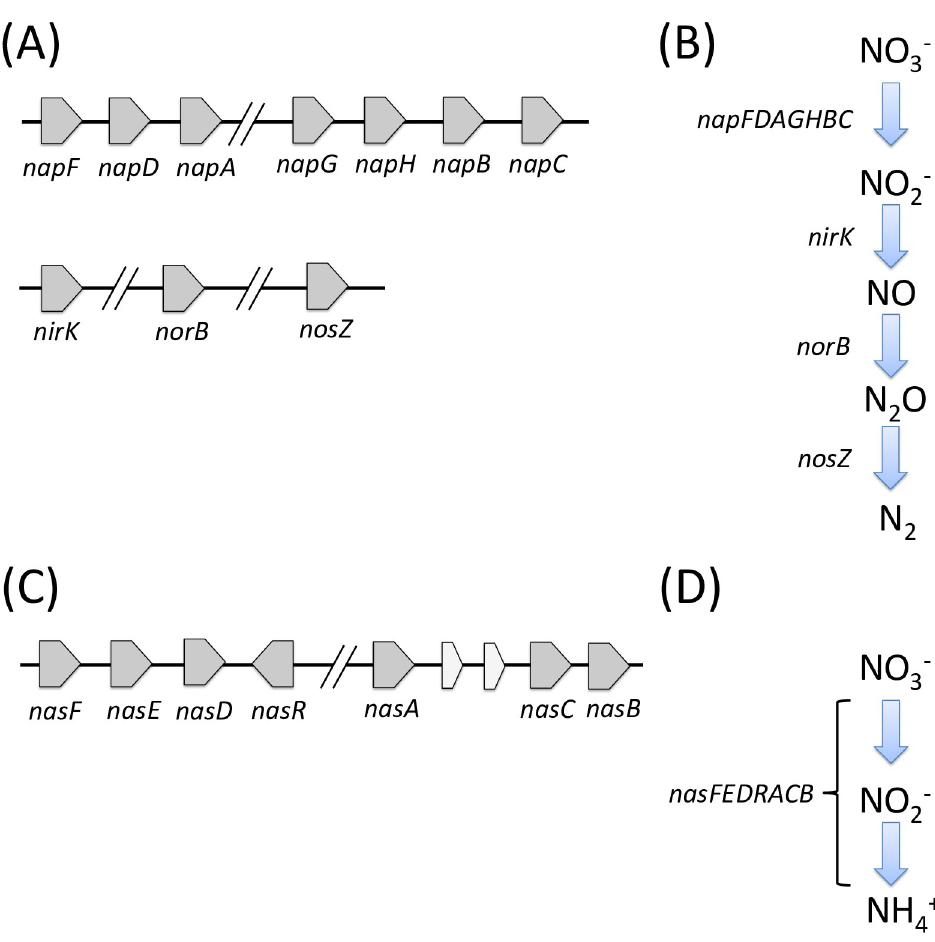
Fig 7. Genes and pathways of denitrification and assimilatory nitrate reduction. (A) Genes and gene clusters that play roles in denitrification. (B) A pathway to convert NO 3- to N 2 adapted from previously studies [38–40].(C) A gene cluster for assimilatory nitrate reduction. (D) A pathway for converting nitrate to